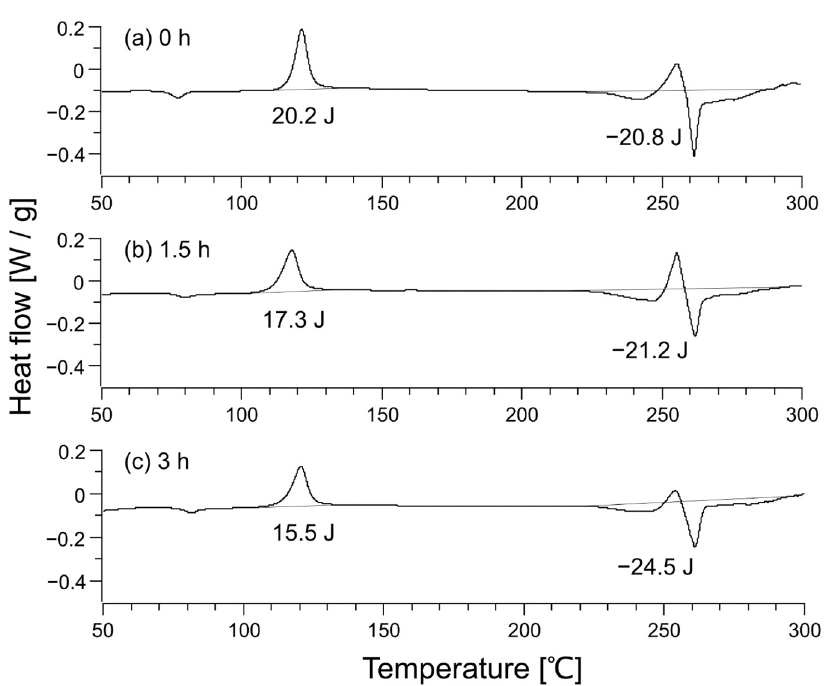
Figure 3. Differential scanning calorimetry profile of unheated sample ( a ), sample after heat treatment for 1.5 h ( b ), and sample after heat treatment for 3 h ( c ). The heat flow in the chart is positive for an exothermic reaction, so the enthalpies listed in the figure correspond to − ∆ H 1 c and − ∆ H 2 c + m in Equation (12).